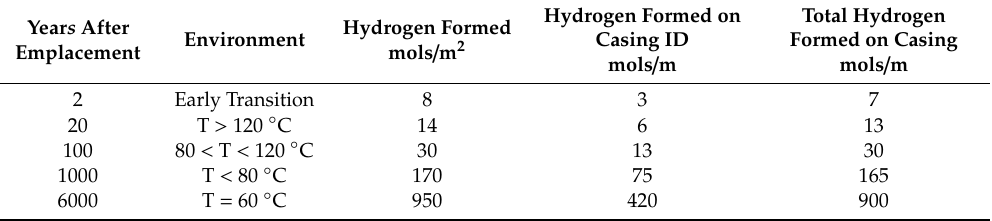
Table 8. Hydrogen formed from corrosion of L80 steel casing per meter per zone.